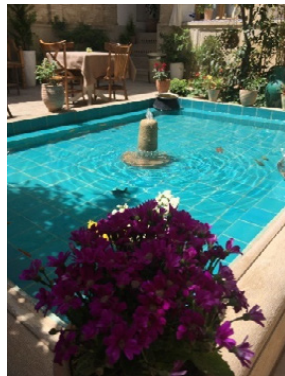
Fig 3: A fountain in the middle of a howz